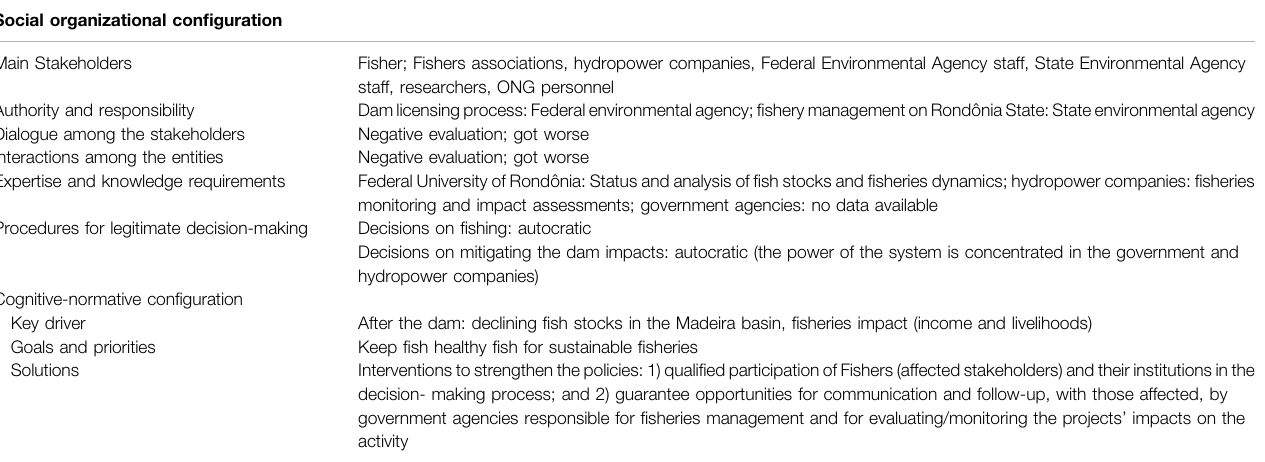
TABLE 4 | The governance architecture of the Madeira Fisheries System after the dam